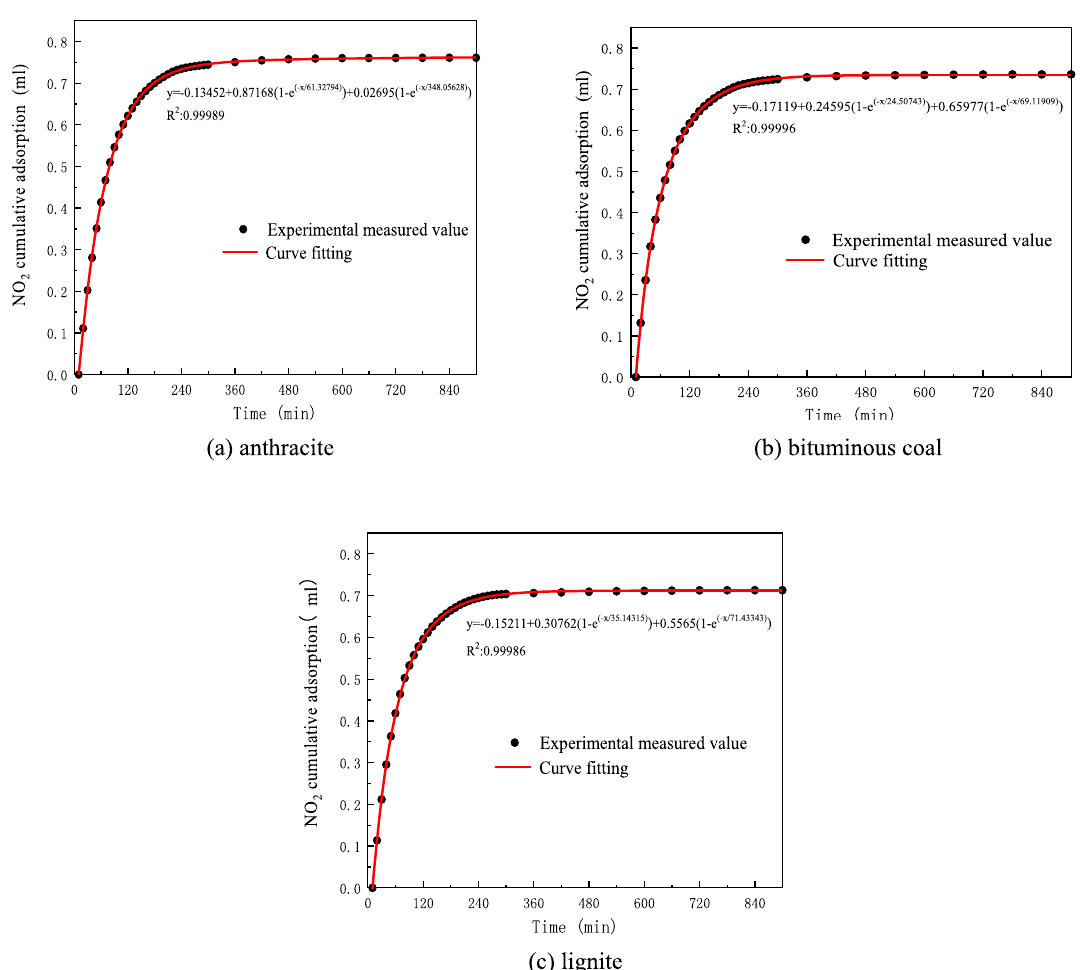
Figure 6. Cumulative adsorption of NO 2 per gram of coal sample with time.